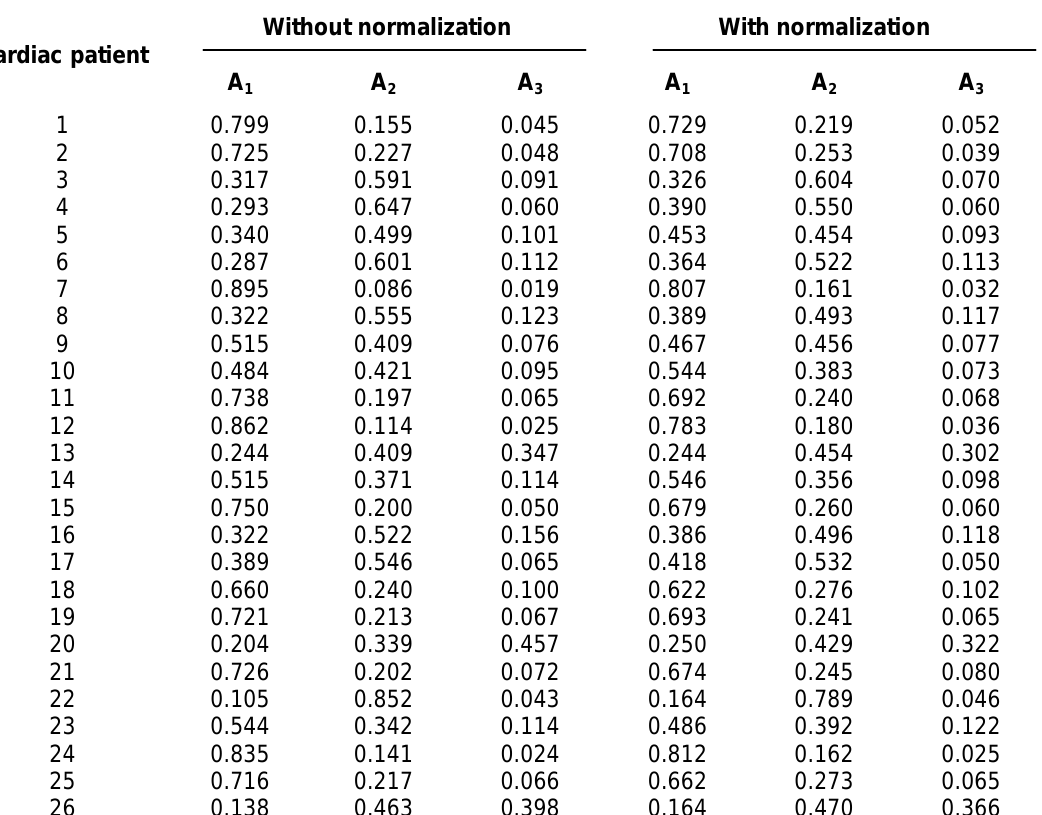
Membership Degrees of the Cardiac Patients to the Classes of the Fuzzy Partition Obtained by Horizontal Fuzzy Clustering using only Seven